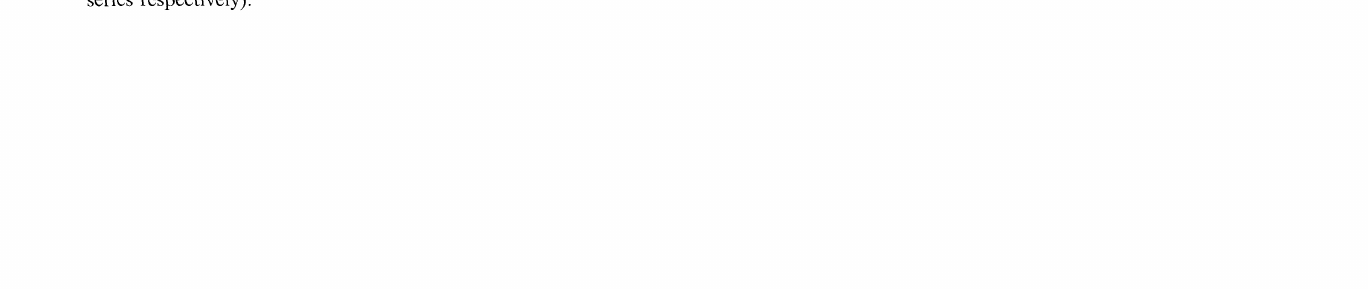
FIGURE 6 Time series of the local principal Lyapunov exponent for the X (upper panel) and Y (lower panel) components of the CW. The plotted exponents are averaged over running windows of 6 and 24 years. High picks in the series correspond to relative losses of stability and reduced horizons of prediction (note that the global exponents are 0.046 and 0.086 for the X and Y series